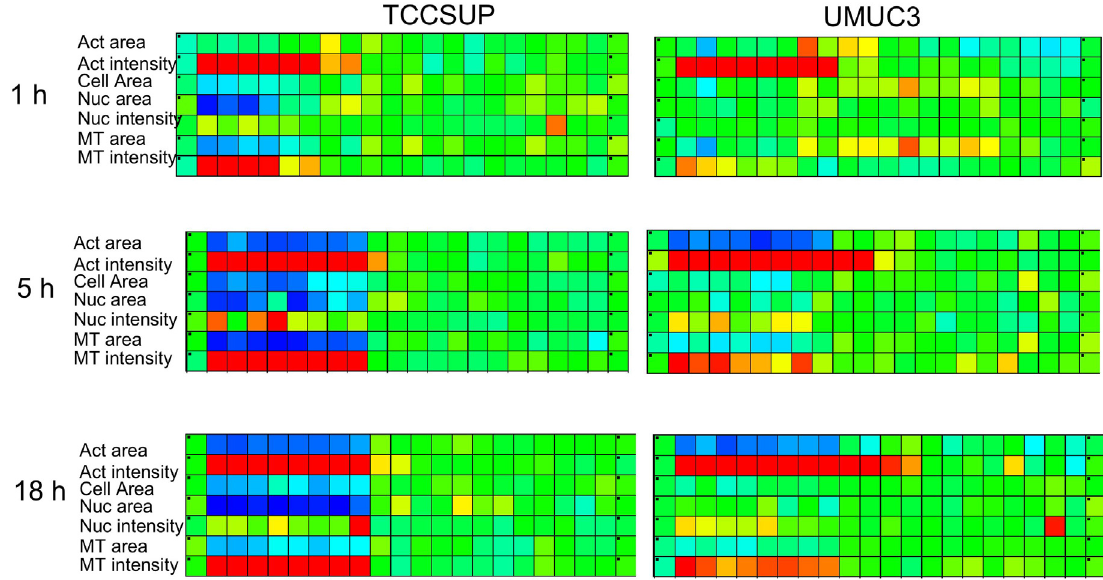
Figure 3. Comparison of short and long-term drug effects on attributes. Three plates were treated with 6 drugs for 3 times: 1, 5 & 18h (shown only Nocodazole for 2 cell lines for several attributes). The “virtual plate” displays in rows the different attributes evaluating cellular effects at different time points. Time-response fingerprinting based on a single attribute depends on the attribute chosen, and is not reliably reporting time-dependence of effects. For example, fast (minutes) disruption of microtubules, indirect effects on the actin filaments (an hour), changes in cell spreading, slower cell-cycle arrest (many hours) and cell death (days) are only reported by several time points.